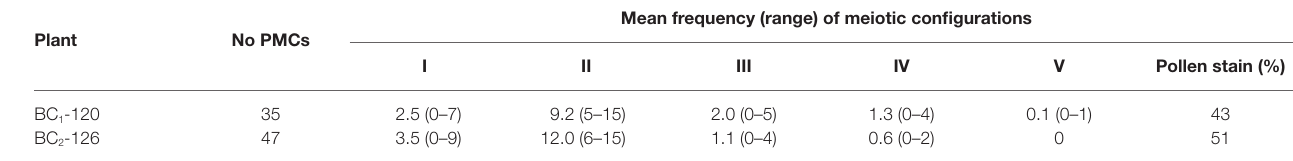
Mean frequency (range) of meiotic